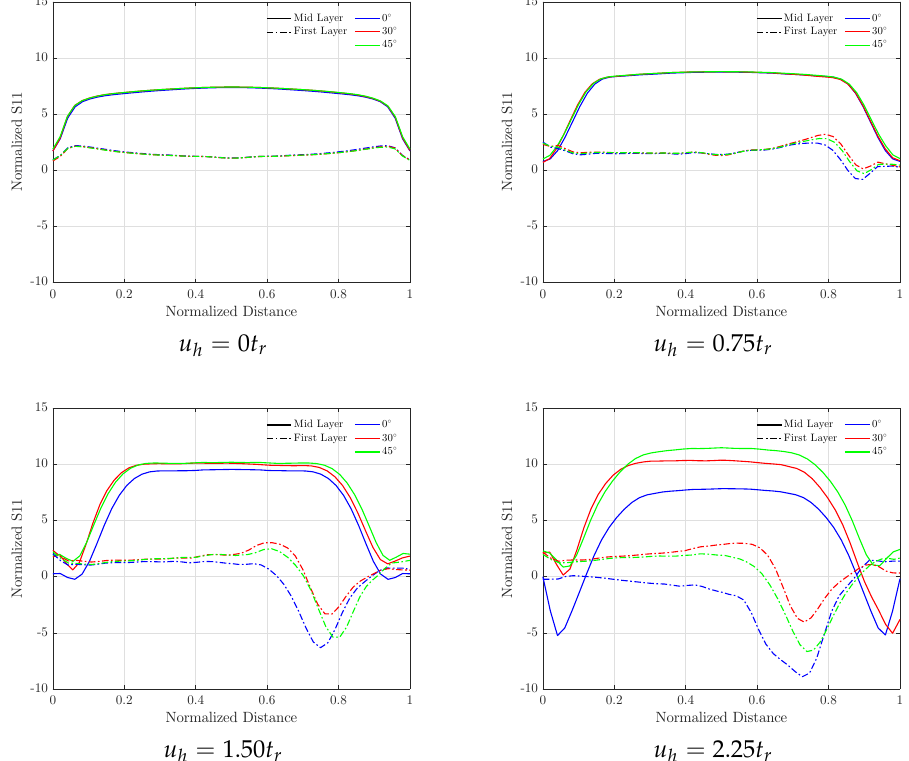
Figure 22. Axial stress S11 on reinforcement along the symmetry axis. Effect of reinforcement orientation. In Figure 23, reinforcement orientations other than 0° cause a softening in the me- chanical behavior after the occurrence of a rollover in which no softening of the effective horizontal stiffness can be detected, while the equivalent damping ratio presents a clear increase for specimens with rotated